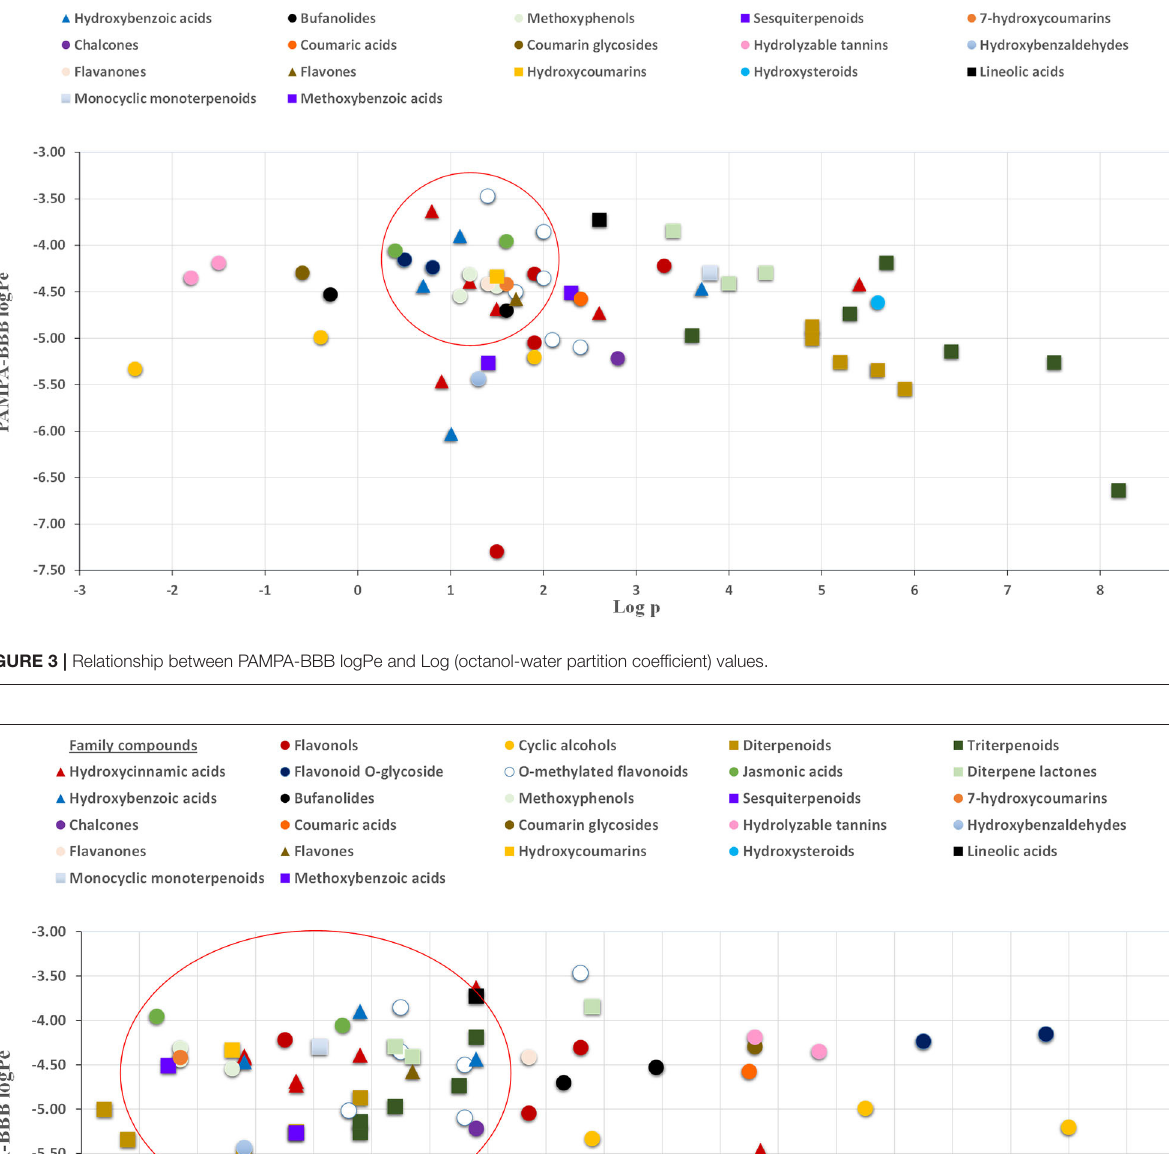
acids have been suggested as safe for SH-SY5Y cells (74). Other plant matrices, such as Dunaliella salina and